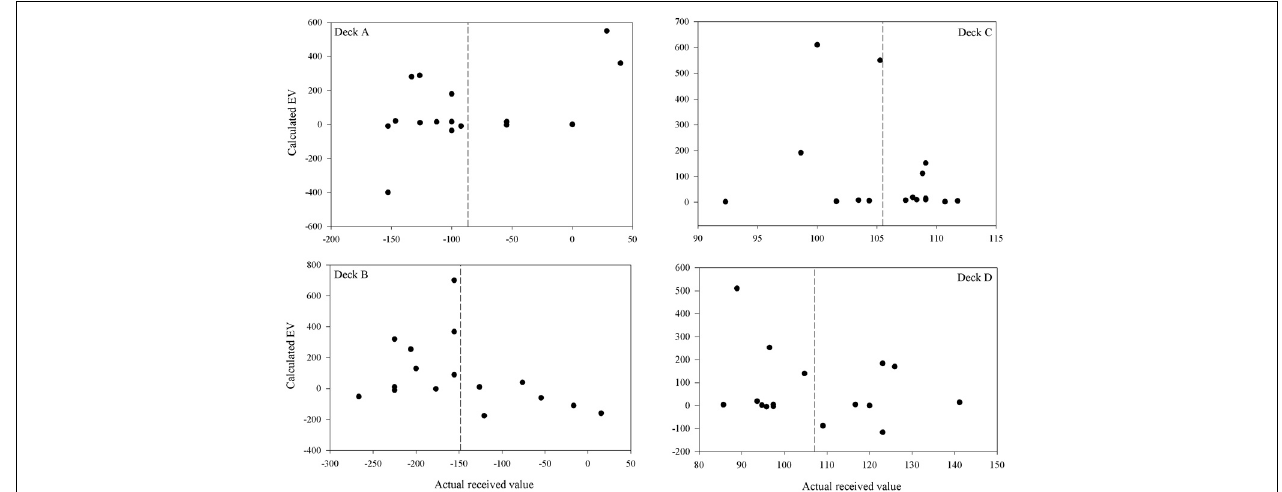
FIGURE 4 | Calculated vs. actual expected value on each deck after 100 trials for each participant (except for participant 3 for whom figures are following 80 trials). The calculated expected value was calculated from a